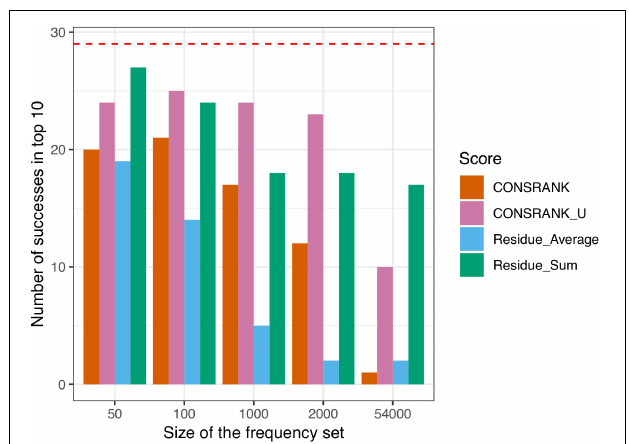
FIGURE 1 | Number of successes after rescoring the first 2,000 solutions of ZDOCK. The size of the frequency set refers to the set of poses used to compute the residue and contact scores from Eqs 1 and 4. The horizontal red dashed line indicates the number of successes achieved by the ZDOCK native scoring